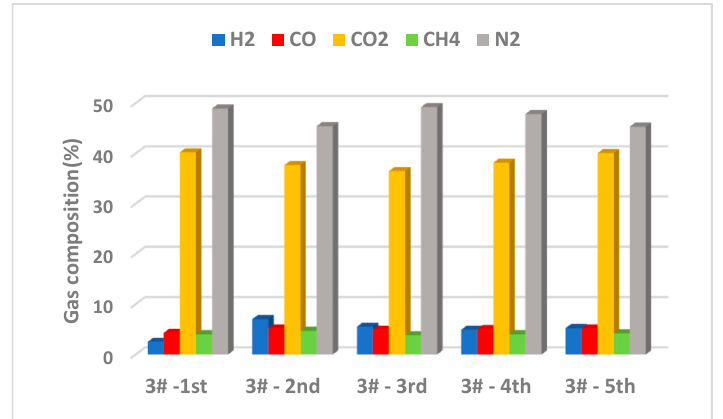
Figure 14. Gas composition for five cycles of experiments using the 3# CaO-Zn/13XZ nanocatalyst .